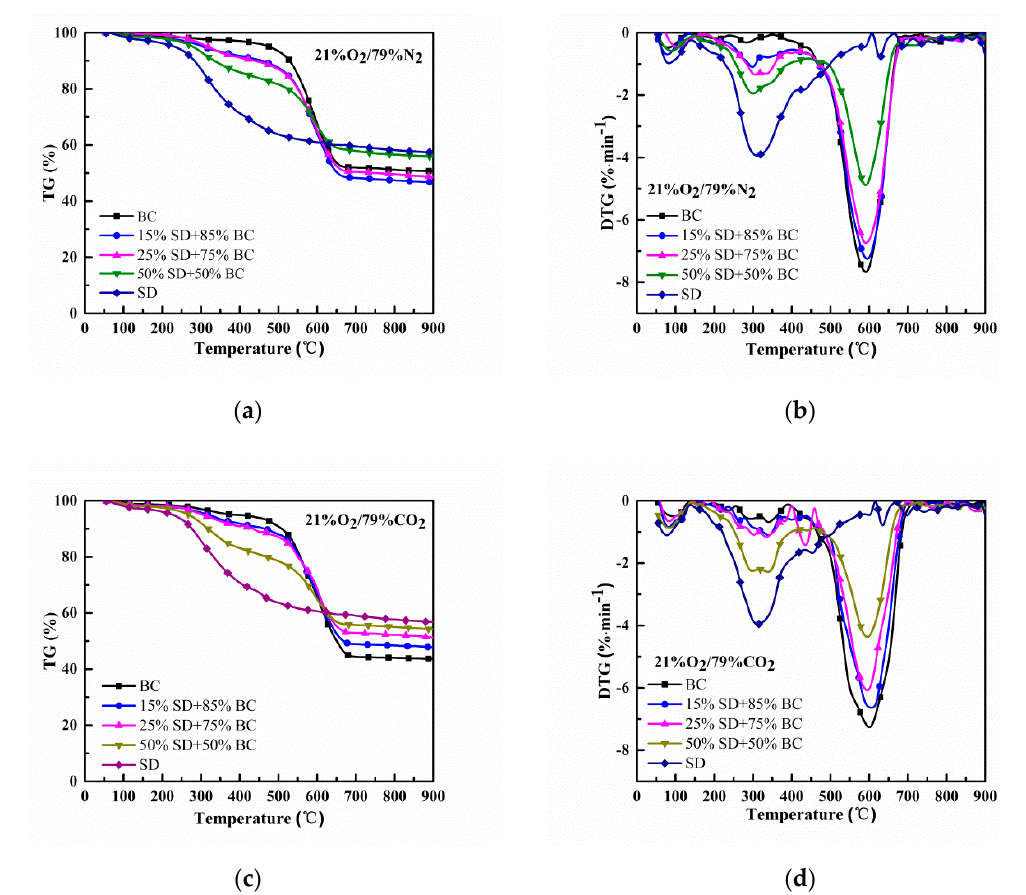
Figure 2. Thermo-gravimetric curve of the samples heating in different atmospheres. ( a ) TG curve in 21% O 2 /79% N 2 conditions; ( b ) DTG curve in 21% O 2 /79% N 2 conditions; ( c ) TG curve in 21% O 2 /79% CO 2 conditions; ( d ) DTG curve in 21% O 2 /79% CO 2 conditions.